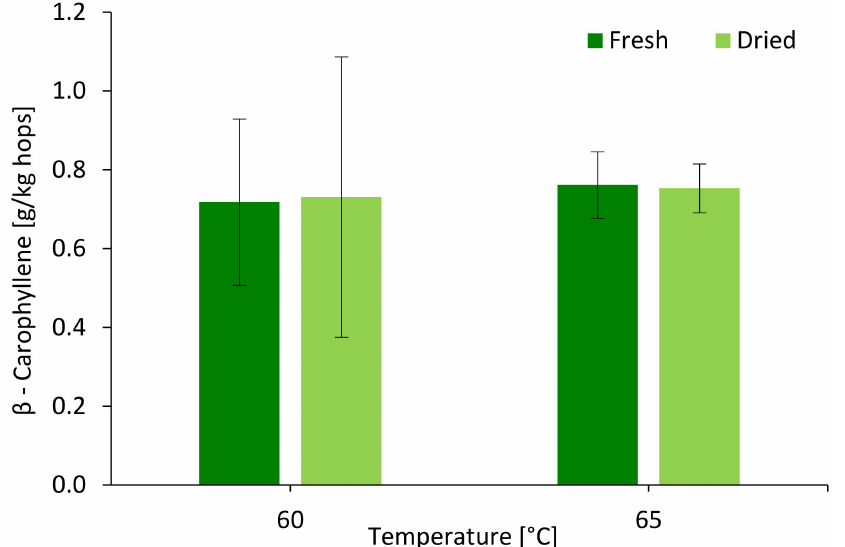
Figure 11. Results obtained from gas chromatography analysis for β -caryophyllene in g / kg hops at 0 min and 210 min for hop cones dried at 60 ◦ C and 65 ◦ C at 0.35 m /